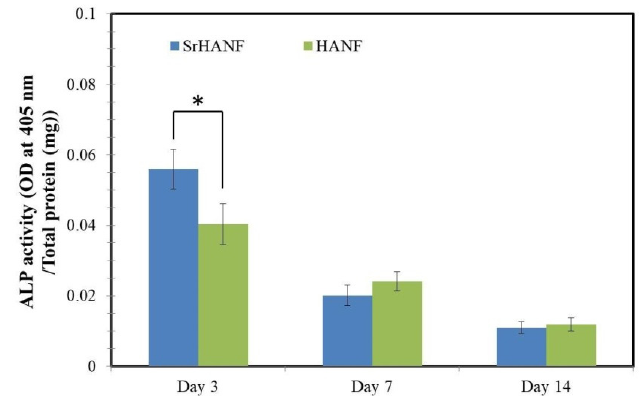
Figure 6. Analysis of alkaline phosphatase activity of cells on SrHANF and HANF matrices. Relative ALP activity of MG63 osteoblast-like cells on SrHANF and HANF after seven days of incubation. The data are presented as the mean ± SD, n = 3. Statistical analysis comparing SrHANF and HANF. (*) Denotes a significant difference ( p < 0.05).